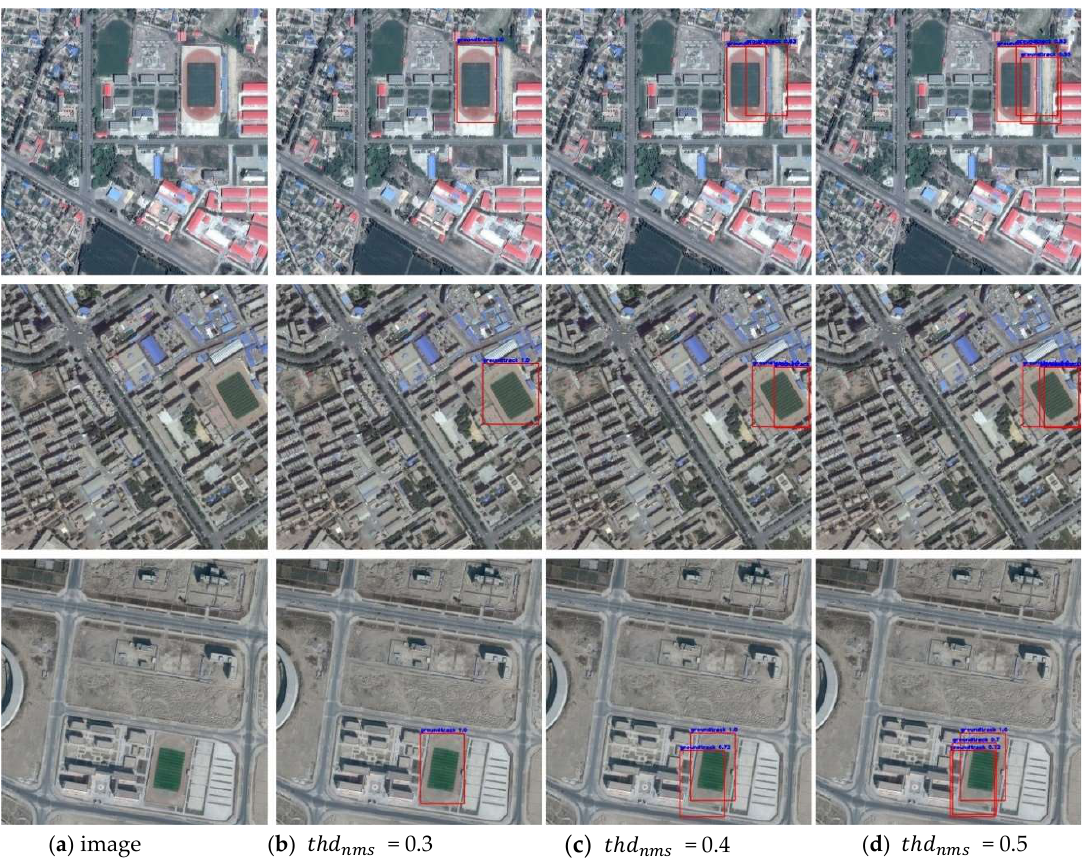
Figure 17. Visualization of different thd nms , the detected track and field is inside the red box: ( a ) The original image; ( b ) The detected results when thd nms is 0.3; ( c ) The detected results when thd nms is 0.4; ( d ) The detected results when thd nms is 0.5.